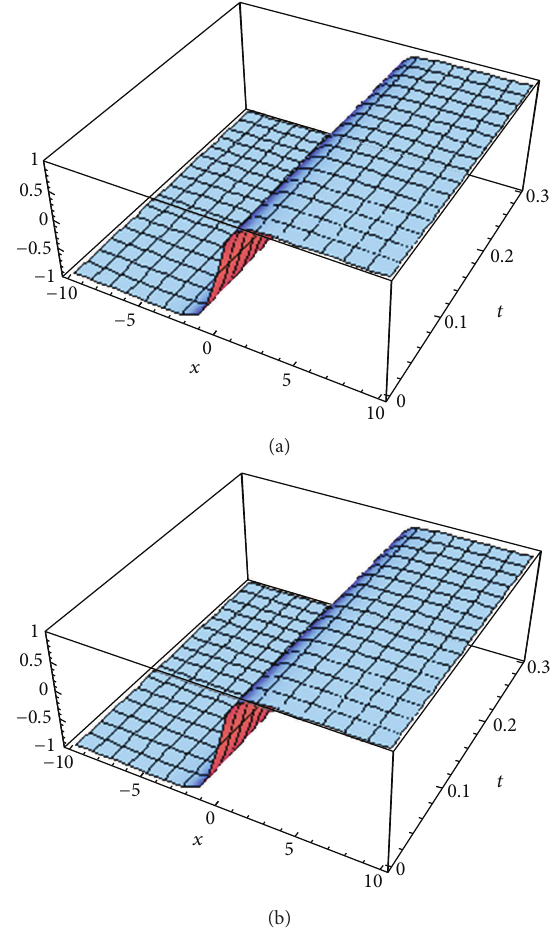
(𝑥,𝑡) are shown, respectively, from (b) to Figure 4: 𝑢(𝑥,𝑡) and 𝑢 app (a), when −10 ≤ 𝑥 ≤ 10 and 0 ≤ 𝑡 ≤ 0.3 , for STO equation with 𝑛 = 8 , 𝛼 = 1 .